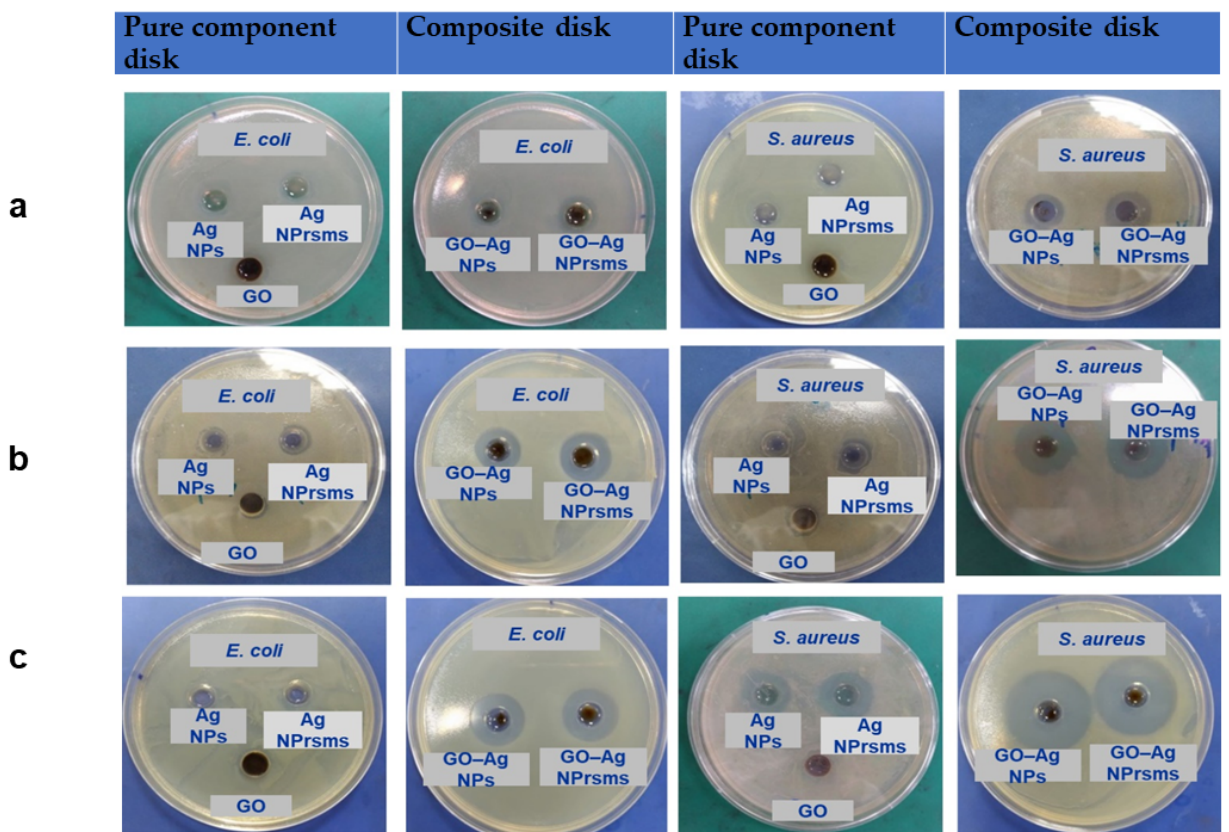
Figure 7. Inhibition zones of E. coli and S. aureus after treatment with GO, Ag NPs, Ag NPrsms, GO-Ag NPs, and GO-Ag NPrsms at nanomaterial concentrations of 25 µg mL − 1 ( a ), 50 µg mL − 1 ( b ), and 100 µg mL − 1 ( c ).